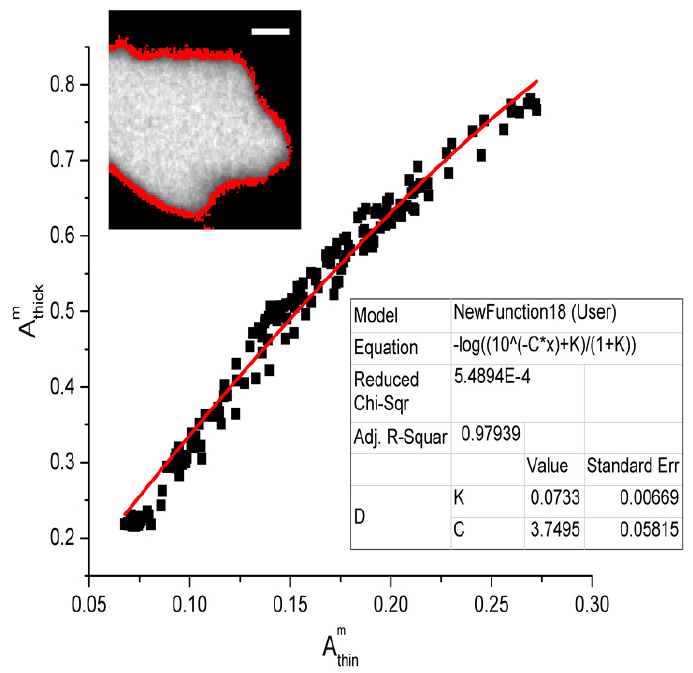
Figure A2. Measured thick absorbance as a function of the measured thin absorbance. The fitted curve is shown with a red line. Fit parameters and corresponding results are also reported. In the inset in the upper right corner, the MnO 2 particle from which the absorbances were extracted is shown with the thin region in red. The scale bar is 200 nm .